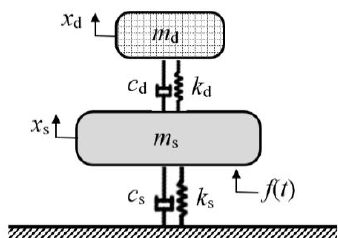
Figure 2. Single degree of freedom mechanical system of passive vibration control.